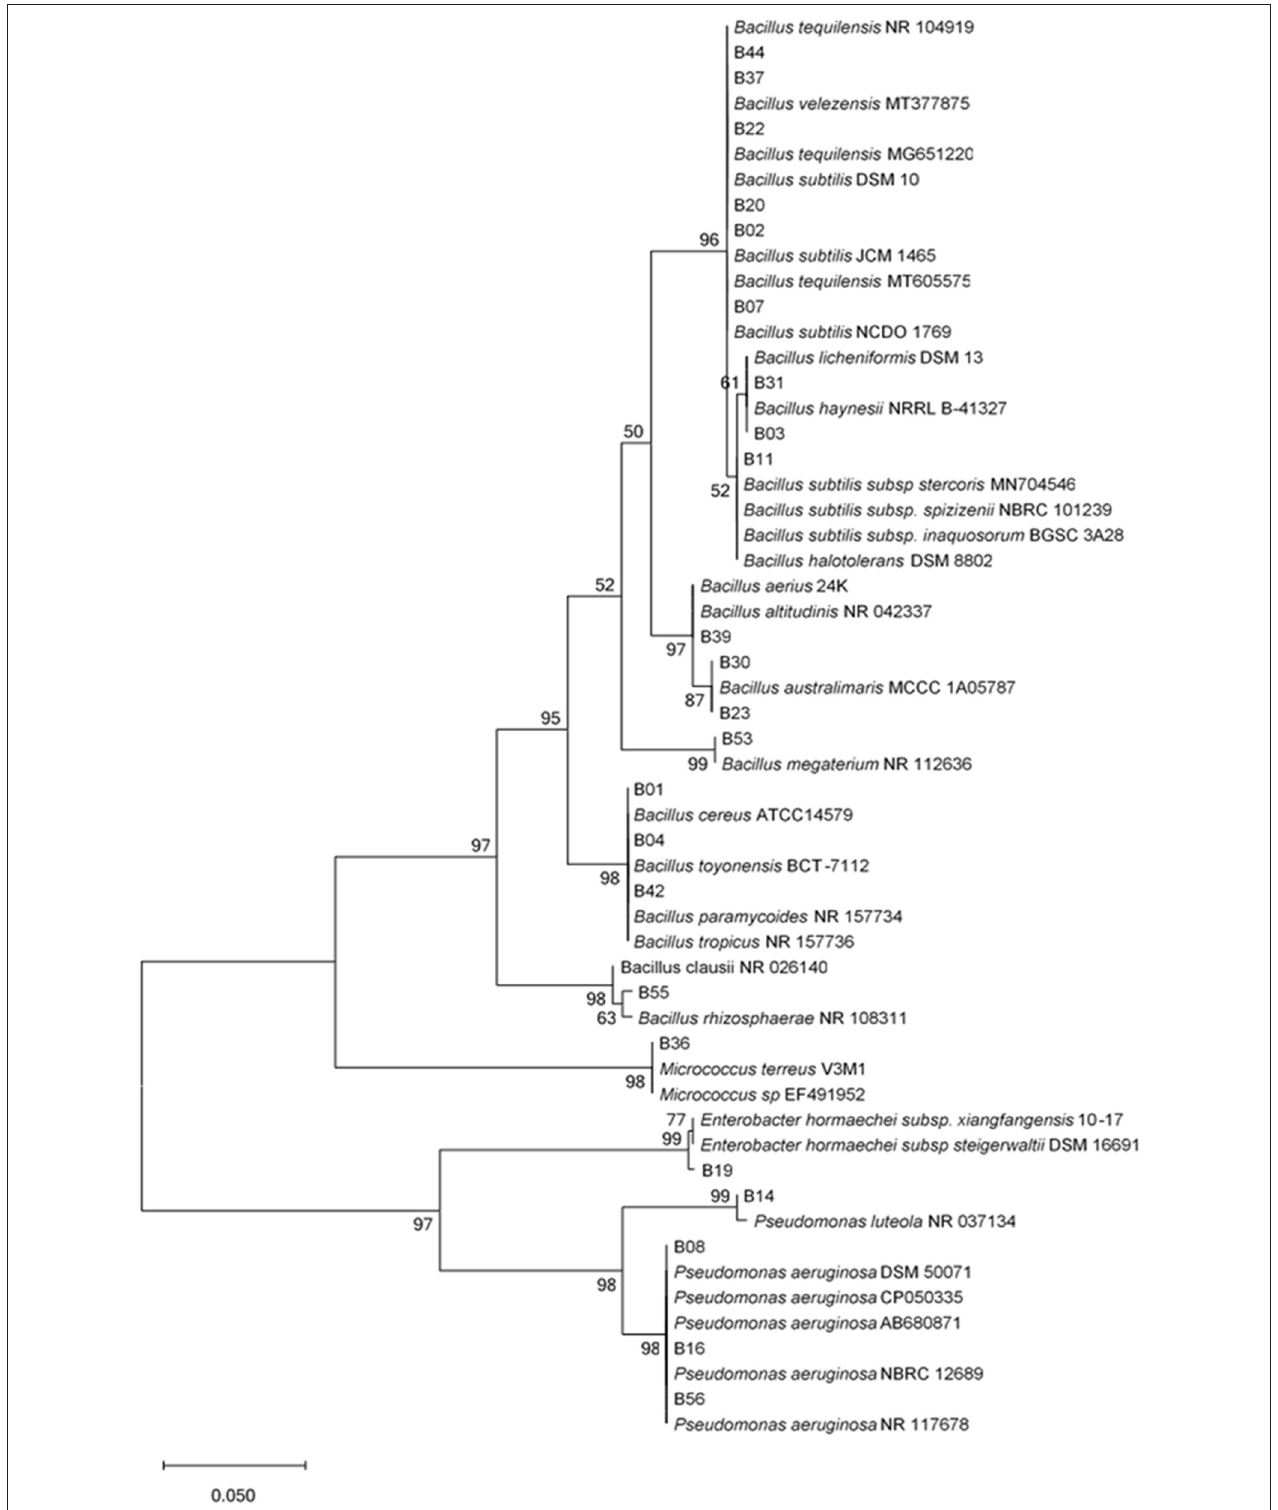
FIGURE 1 | Unrooted phylogenetic tree of endophytic bacterial 16S rRNA sequences. Evolutionary history was inferred using the Maximum Likelihood method with 1,000 bootstrap replicates in MEGA X software. Scale bar represents 0.05 nucleotide substitutions per site. The percentage of trees in which the associated taxa clustered together is shown next to the